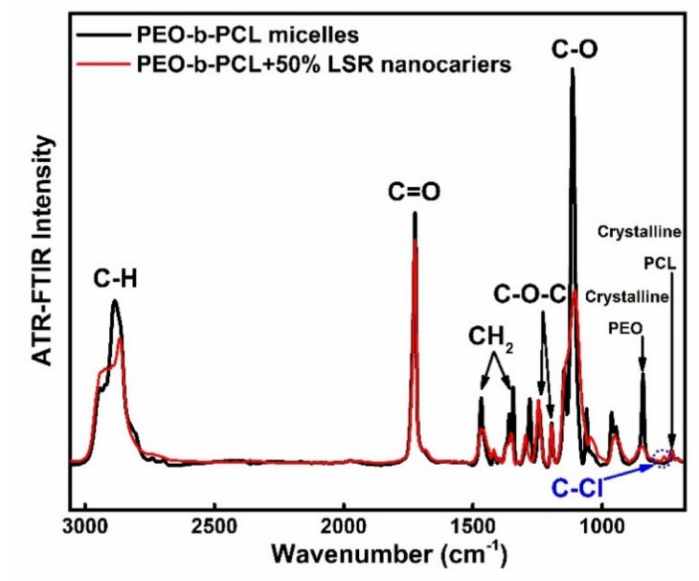
Figure 3. Comparison of ATR-FTIR spectra for PEO-b-PCL micelles and PEO-b-PCL + 50%LSR nanocarriers in aqueous solutions using the organic solvent evaporation